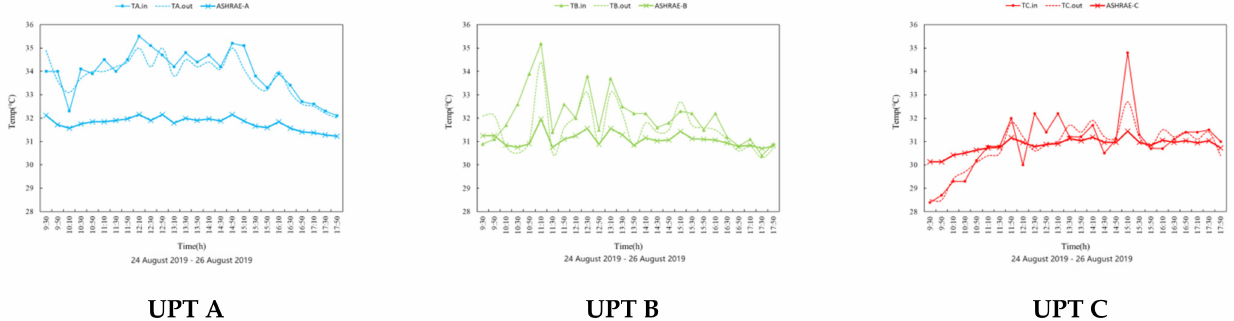
Figure 1. Air temperature and relative humidity changes in tested